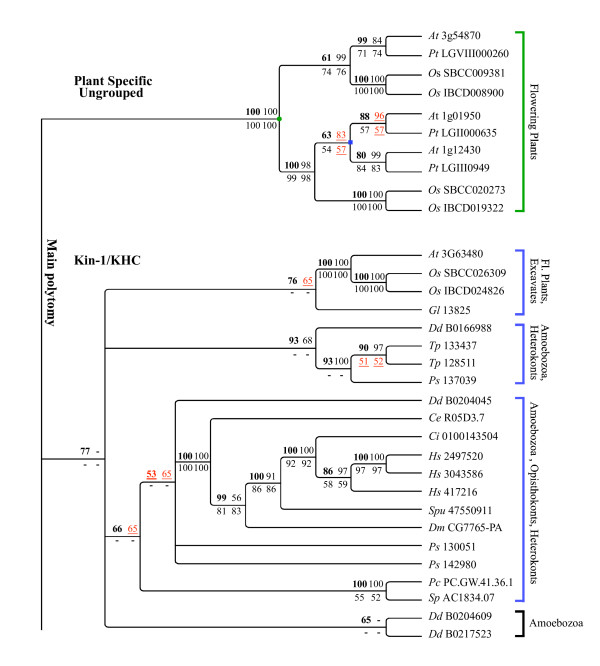
Expanded view of plant-specific ungrouped kinesins and Kinesin-1 family. Expansion of the plant-specific ungrouped and Kinesin-1 clades from Fig. 2. Green brackets indicate plant specific groups, mixed clades are shown in blue brackets and black brackets indicate protozoan species. Green circle and blue square indicate gene duplications in flowering plants and dicots, respectively. See Fig. 2 legend for an explanation of support values. Support values in italicized blue font indicate those clades supported in the parsimony analyses except for the exclusion of Ps 128382 (see text). For full names of species see Fig. 1 legend. Fl. Plants, flowering plants.